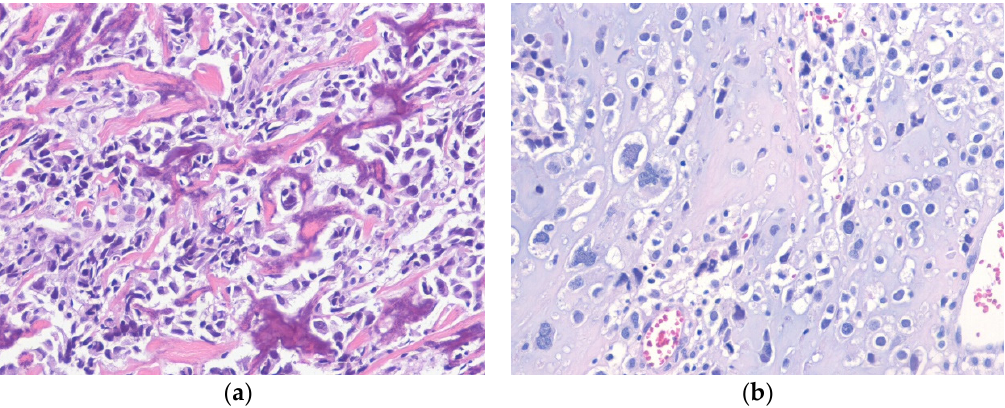
Figure 9. Extraskeletal osteosarcoma. ( a ) The tumor consists of hyperchromatic tumor cells producing lace-like neoplastic bone. ( b ) The tumor shows a cartilaginous area (H&E stain, original magnification 200× a and 200× b